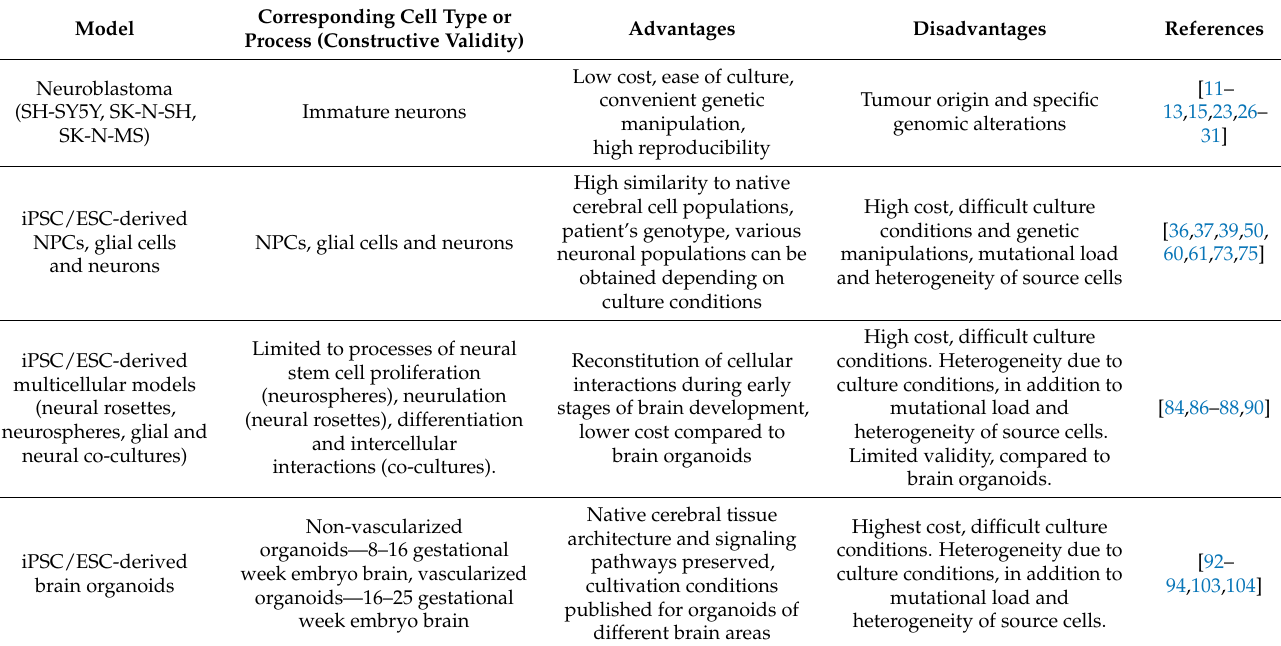
Table 2. Properties of in vitro models used in SZ research.